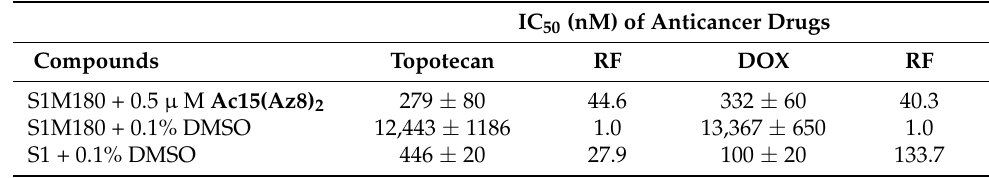
Table 1. Effect of Ac15(Az8) 2 on reversing topotecan and DOX resistance in S1M180 cells.